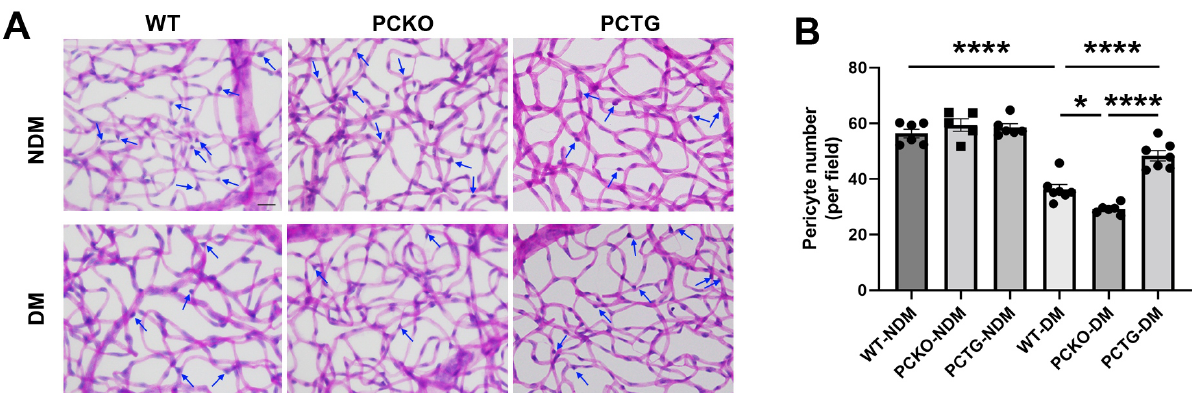
Figure 5. Exacerbated pericyte loss in diabetic PCKO mice. ( A ) Retinal vasculature was prepared by trypsin digestion followed by periodic-acid-Schiff staining. Scale bar: 20 µ m. Pericytes (arrows) were counted and compared. Scale bar: 20 µ m. ( B ) Quantitative analysis of retinal pericyte density. n = 5–6. Data are presented as mean ± SD. * p < 0.05, **** p < 0.0001, one-way ANOVA with